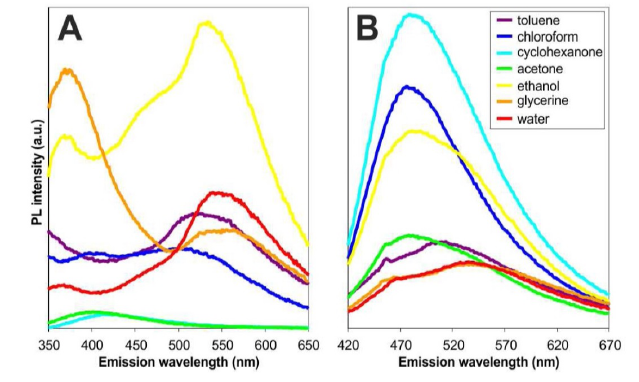
Figure 11. Emission spectra of CDs in different solvents excited at 290 nm ( A ) and 400 nm ( B ). Reproduced with permission from [32]. Copyright American Chemical Society,